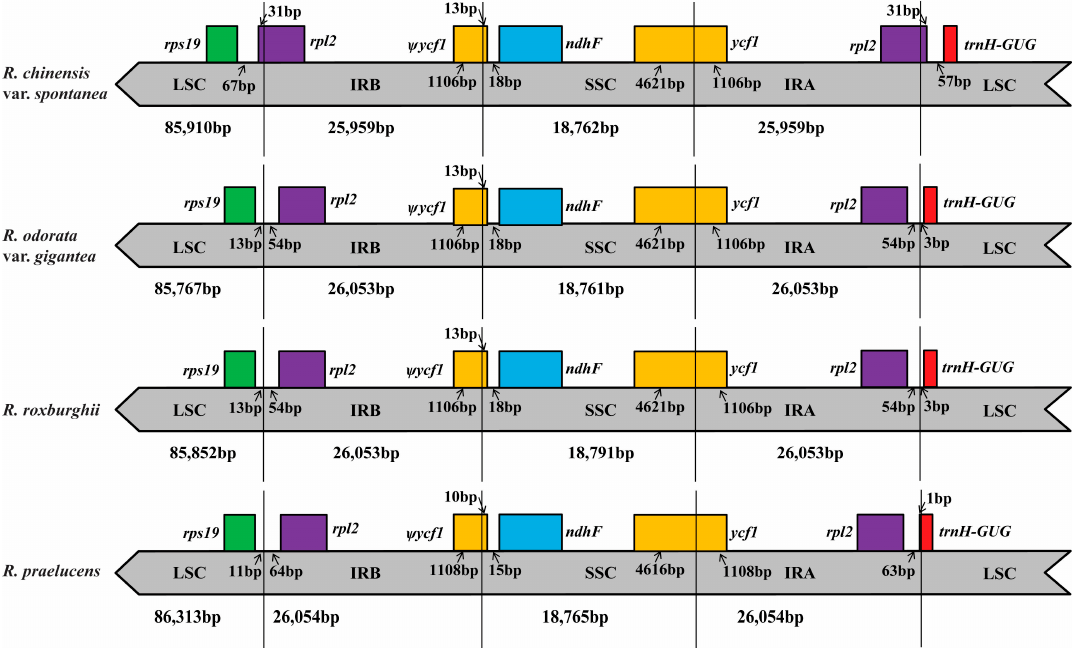
Figure 3. Comparison of the LSC, SSC and IR regions in chloroplast genomes of four species. Ψ : pseudogenes, → : distance from the edge.